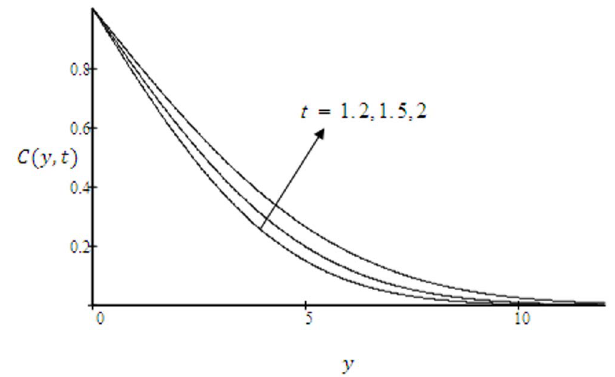
Figure 12. Concentration profiles for t ~ 1 : 2 and different values of Sc .